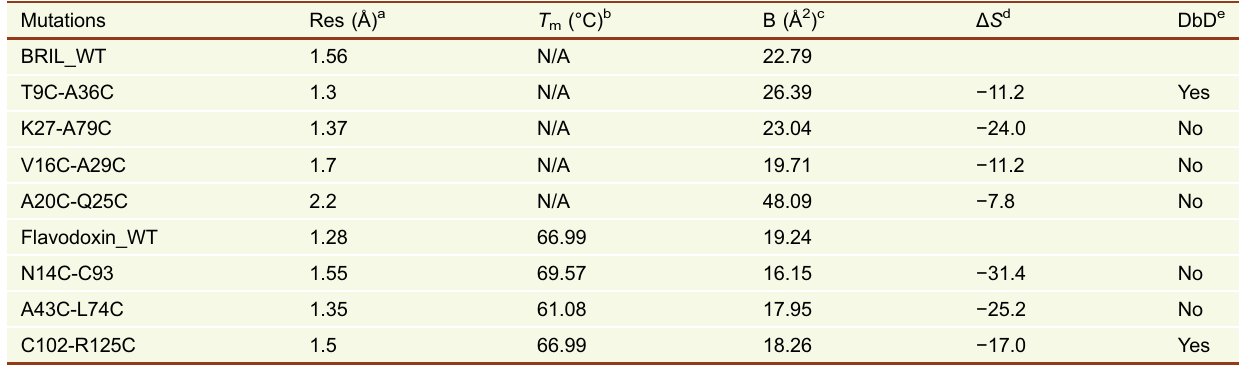
Table 1. Data summary of crystallized BRIL, Flavodoxin and their mutants